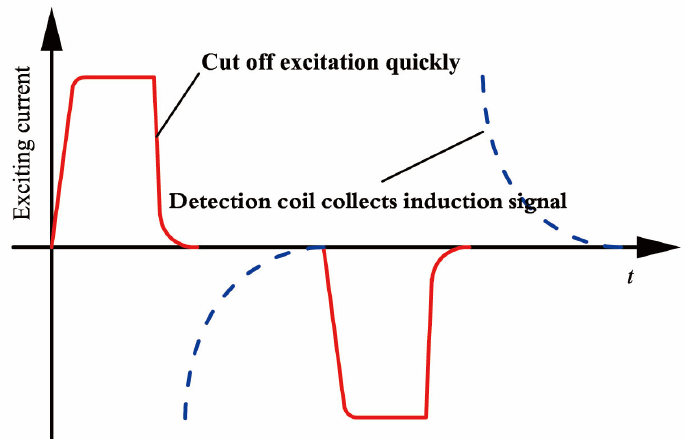
Figure 2. Diagram of pulsed eddy current excitation and reception signals.